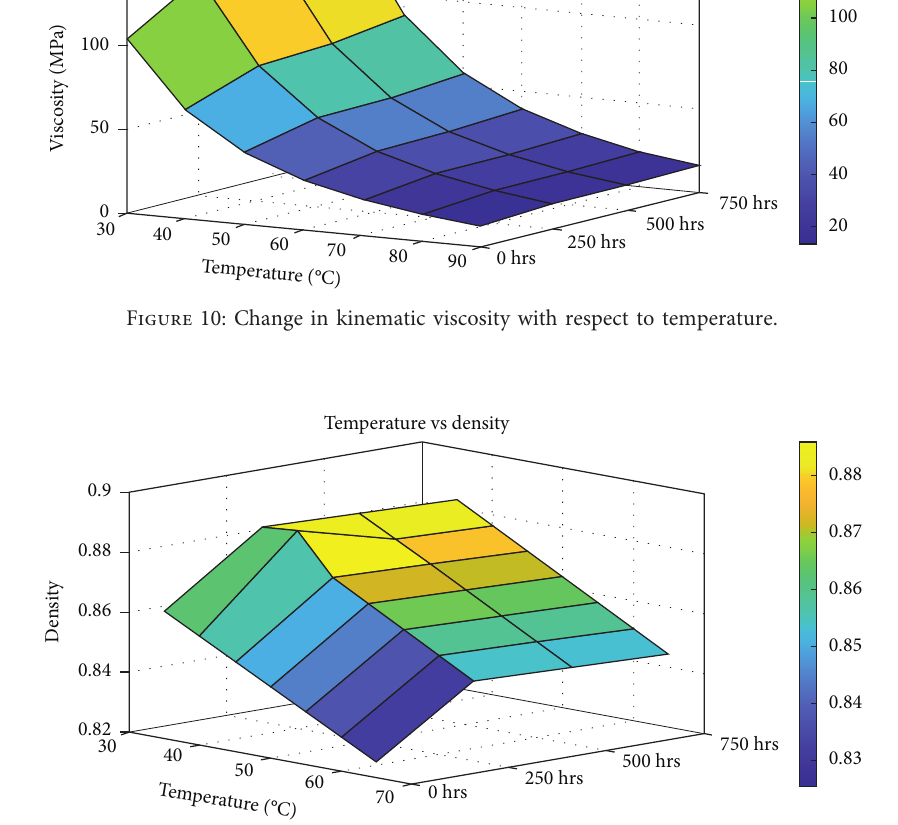
Figure 11: Change in density with respect to